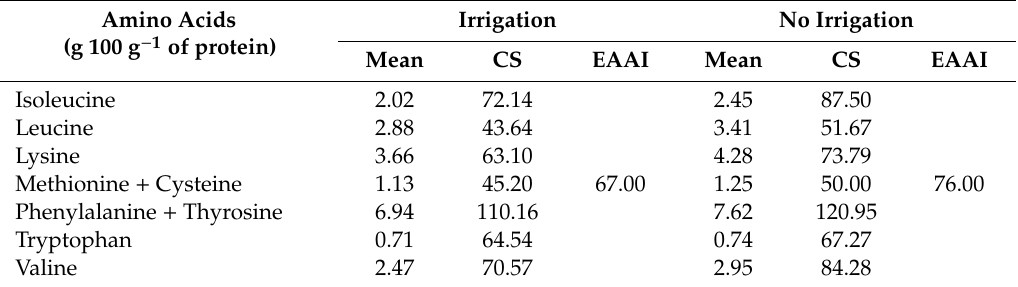
Table 8. The e ff ect of irrigation on the nutritional value of protein in Jerusalem artichoke tubers. Amino Acids (g 100 g − 1 of protein)